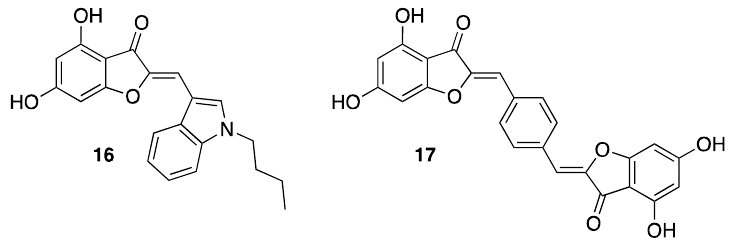
Figure 5. Representative examples of synthetic anti-HCV aurones.